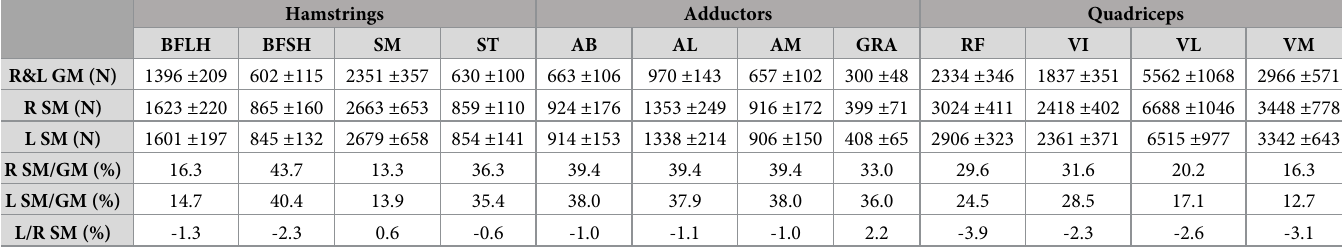
Table 2. Maximum isometric muscle forces in generic and subject-specific models. Hamstrings